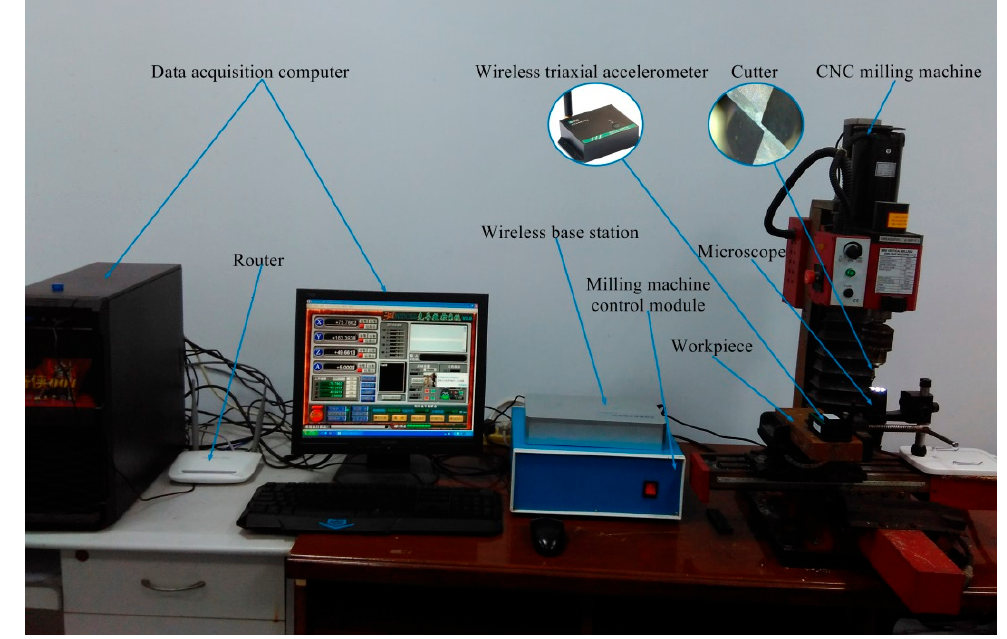
Figure 3. The experimental setup of TCM) and Remaining Useful Life (RUL) prognostic system.